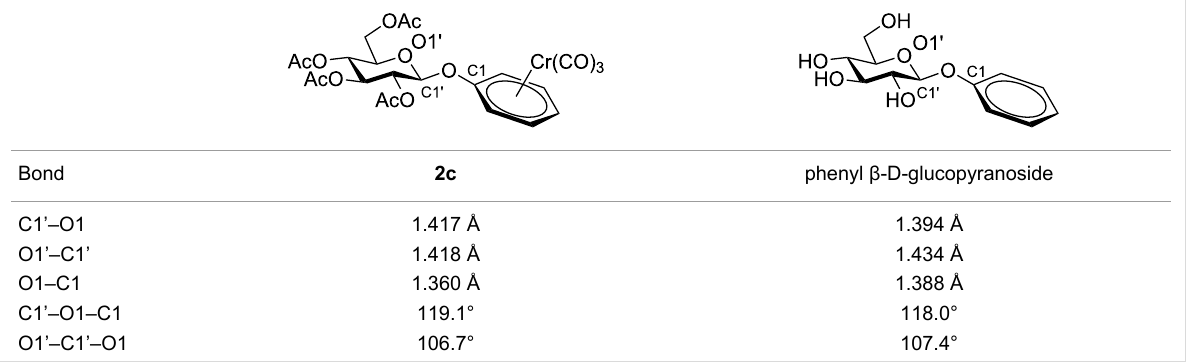
Table 5: Comparison of selected distances and angles in 2c with phenyl β -D-glucopyranoside.